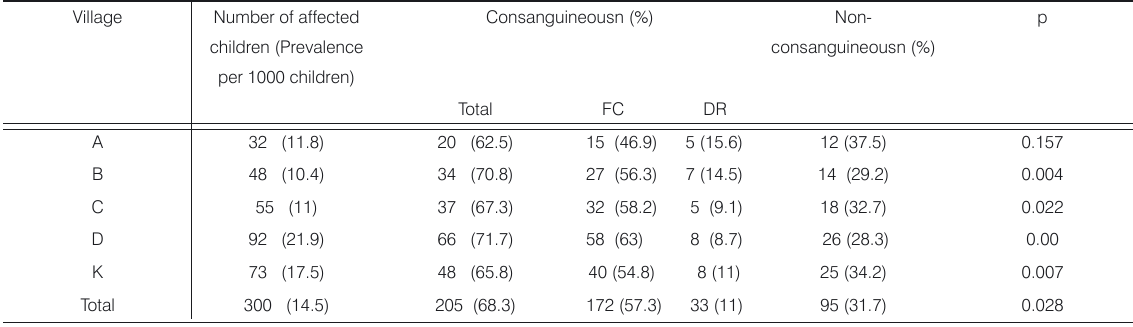
Table 1. Total Numbers of Mentally Retarded Offspring from Consanguineous and Non-Consanguineous Marriages in Five Selected Villages.